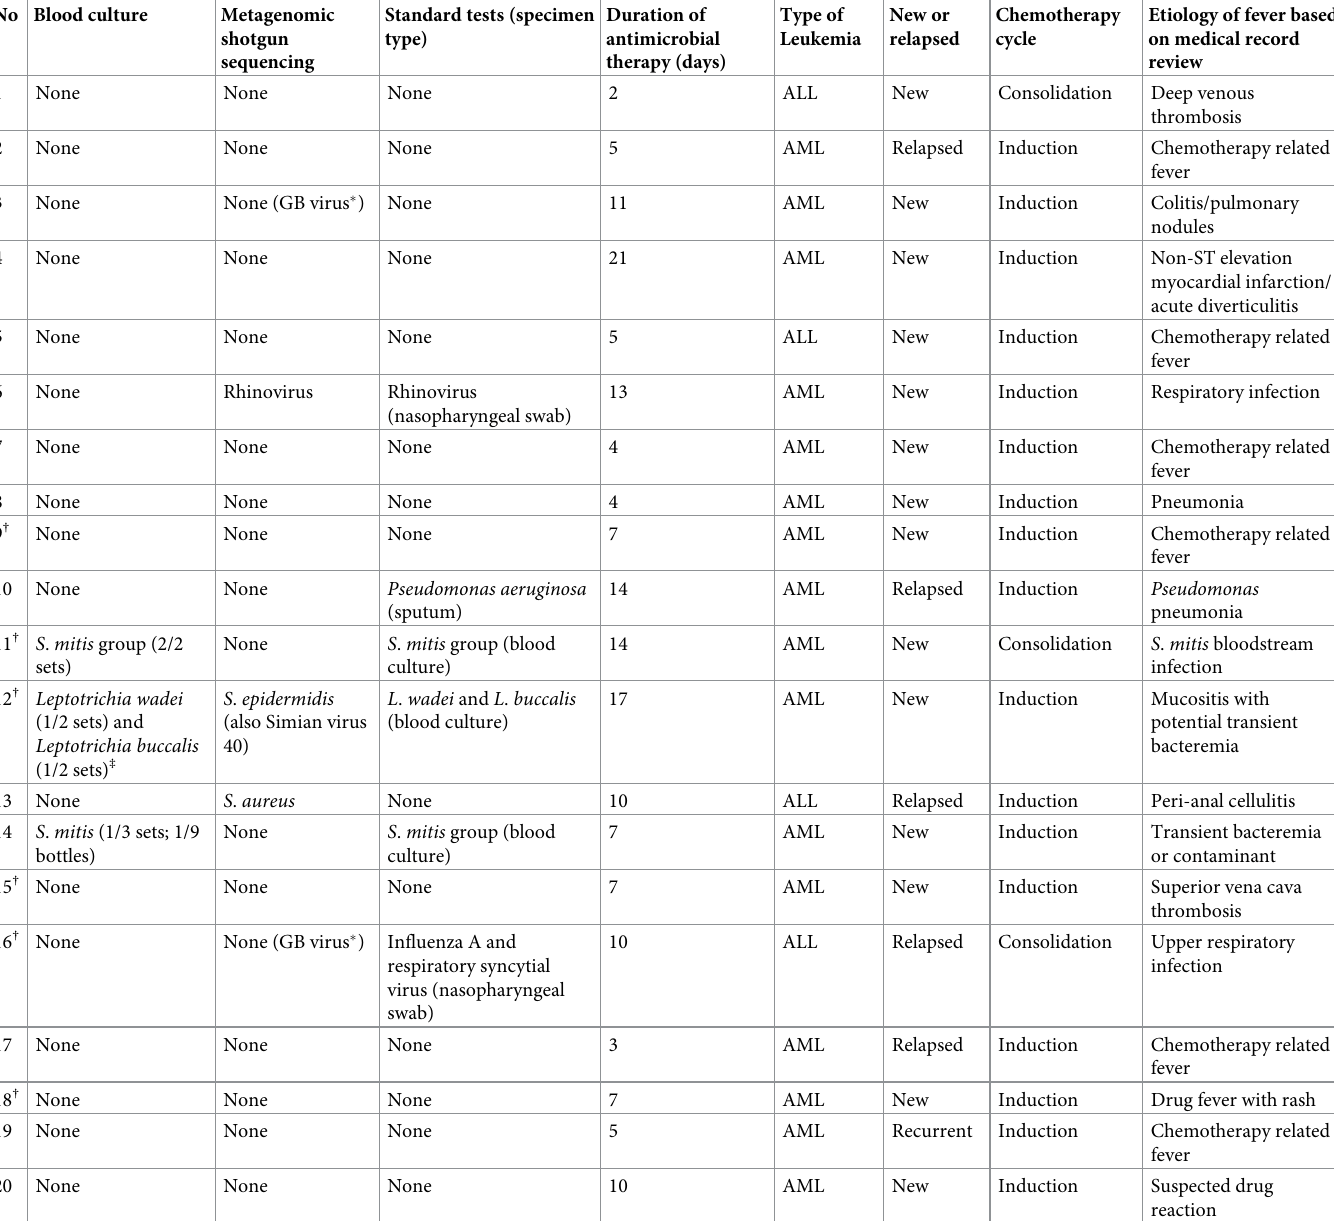
Table 2. Metagenomic shotgun sequencing versus blood cultures and standard microbiological results. No Blood